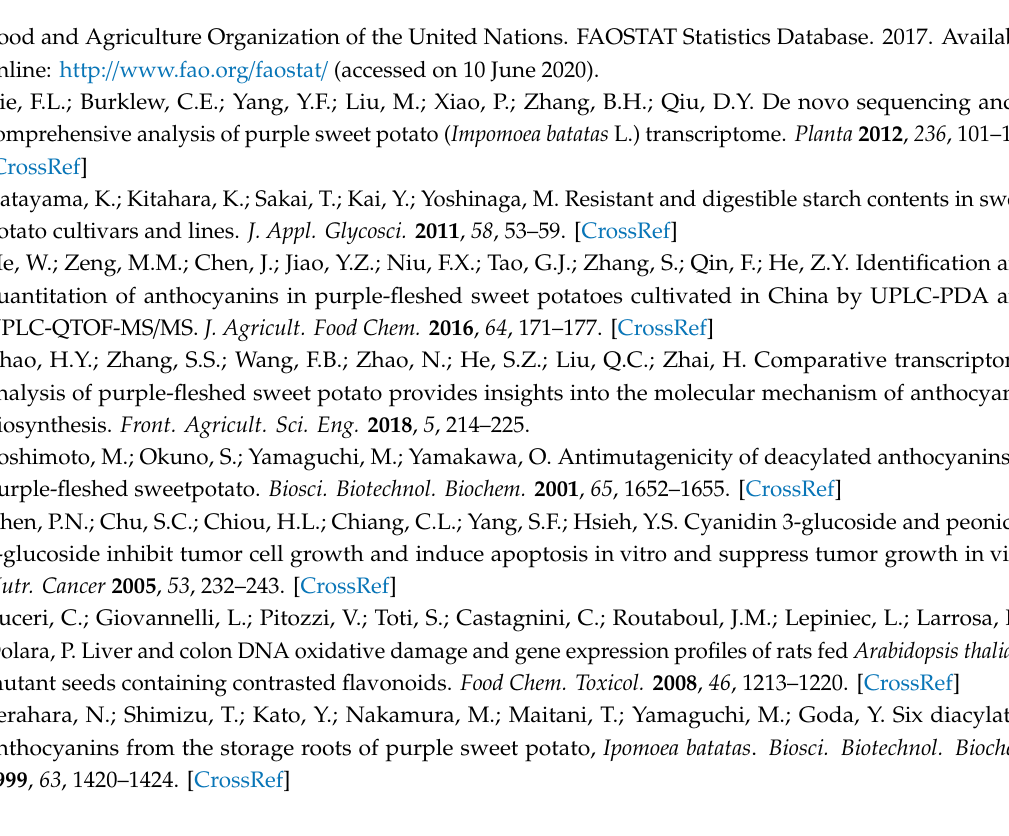
Figure S1: Metaphase cells of aneuploids. Figure S2: Metaphase cells of sweet potato cultivars with the number of 45S rDNA is 16, 17, 19, 20, 21. Figure S3: Metaphase cells of sweet potato cultivars with the number of 5S rDNA is 5, and